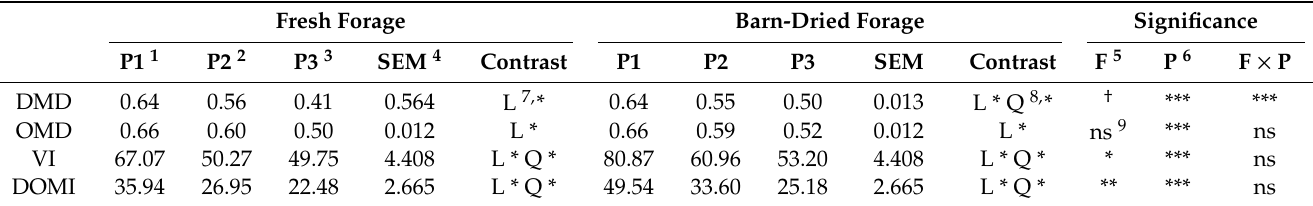
Table 4. Average values of the grassland in the three cuts, and significance levels obtained in the analysis of variance developed for dry matter digestibility (DMD) (g / g), organic matter digestibility (OMD) (g / g), voluntary intake (VI) (g / kg BW 0.75 ), and digestible organic matter intake (DOMI) (g / kg BW 0.75 ). Fresh Forage Barn-Dried Forage Significance